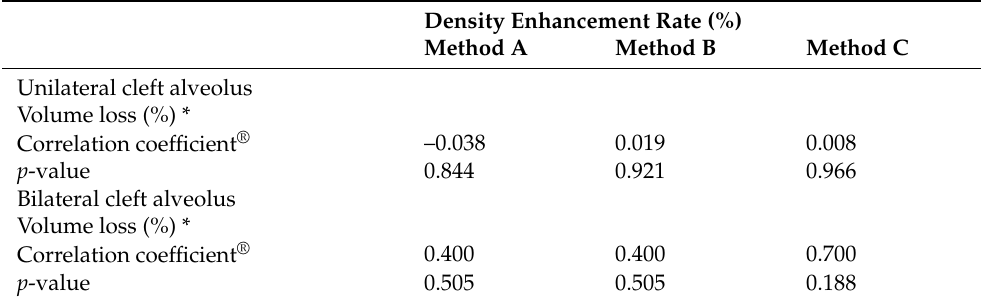
Table 3. The correlation between volumetric loss and density enhancement rate of the grafted tissue was calculated using Spearman’s